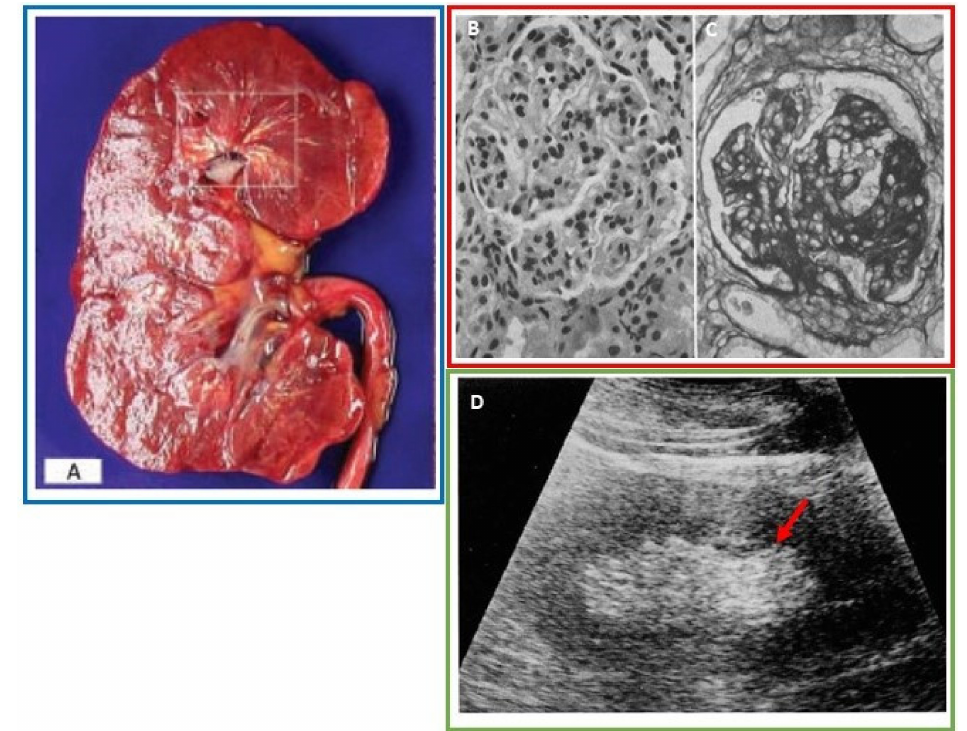
Figure 2. ( A ) Thin, linear, yellowish urate deposits within the renal medulla and pyramids. Reprinted from Incontinence & Pelvic Floor Dysfunction; Hsu, Y.H.; Chronic Urate Nephropathy; 2012; 6(3):89 with permission from the O ffi cial Journal of the Taiwanese Continence Society and Taiwan Urogynecology Association [31]. ( B ) Hematoxylin and eosin (H&E) stained section (original magnification × 575) reveal moderate glomerulosclerosis with prominent nuclei, thickened capillary walls, and prominent capillary epithelial cells [34]. ( C ) Periodic acid-Schi ff (PAS) stained section (original magnification × 575) reveal advanced glomerulosclerosis with more prominent thickening of the capillary walls and axillary stroma. With permission from Annals of Internal Medicine , Gonick, H.C., et al. The Renal Lesion in Gout. 1965;62:667–74. Copyright © 1965 American College of Physicians. All rights reserved. Reprinted with the permission of American College of Physicians, Inc. [34]. ( D ) Renal ultrasound demonstrates increased echogenicity within the renal medulla (red arrow). Adapted with permission from Kim, M.Y. J. of Korean Radiol. Soc. 1994 Sep;31(3):523–527. Copyright © The Korean Radiological Society